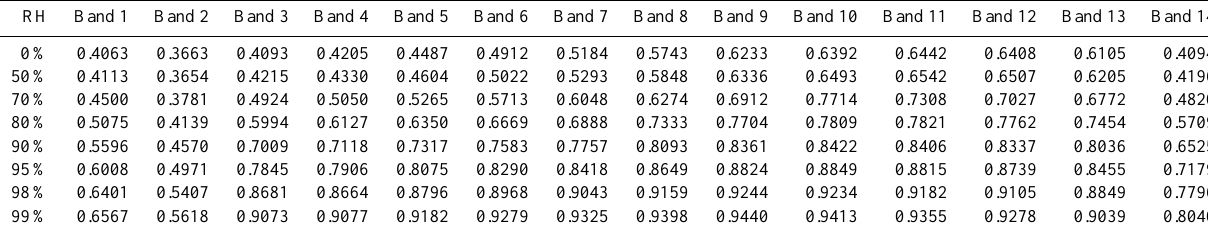
Table A4. Single-scattering albedo for the urban aerosol mixture. RH